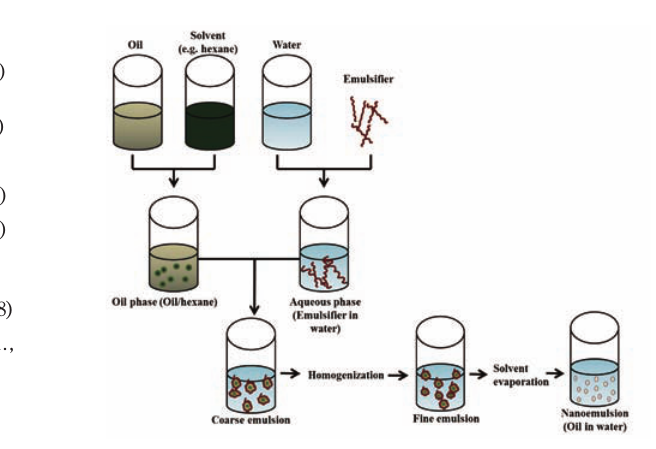
Fig. 4 High energy process of nanoemulsion prepara- tion (adapted from (Troncoso, 2012)).